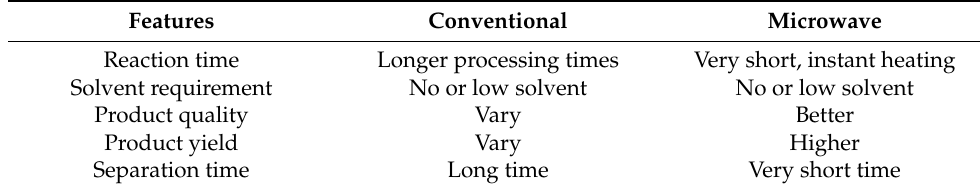
Table 1. Comparison of conventional and microwave